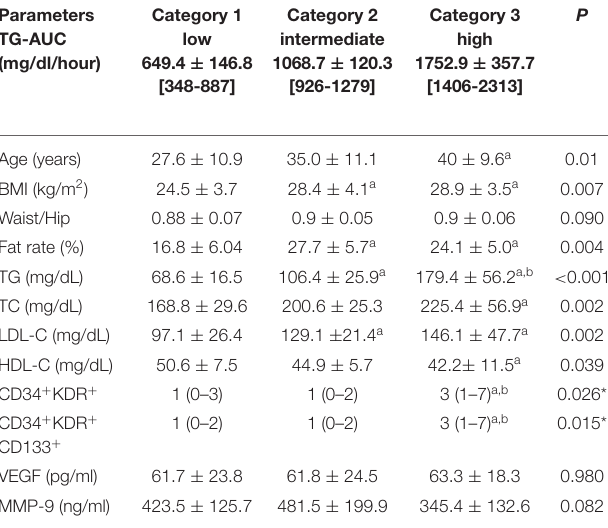
TABLE 3 | Physical characteristics and biochemical and immunological parameters in men according to the three categories of TG-AUC ( n = 14), mean ± SD [min–max].